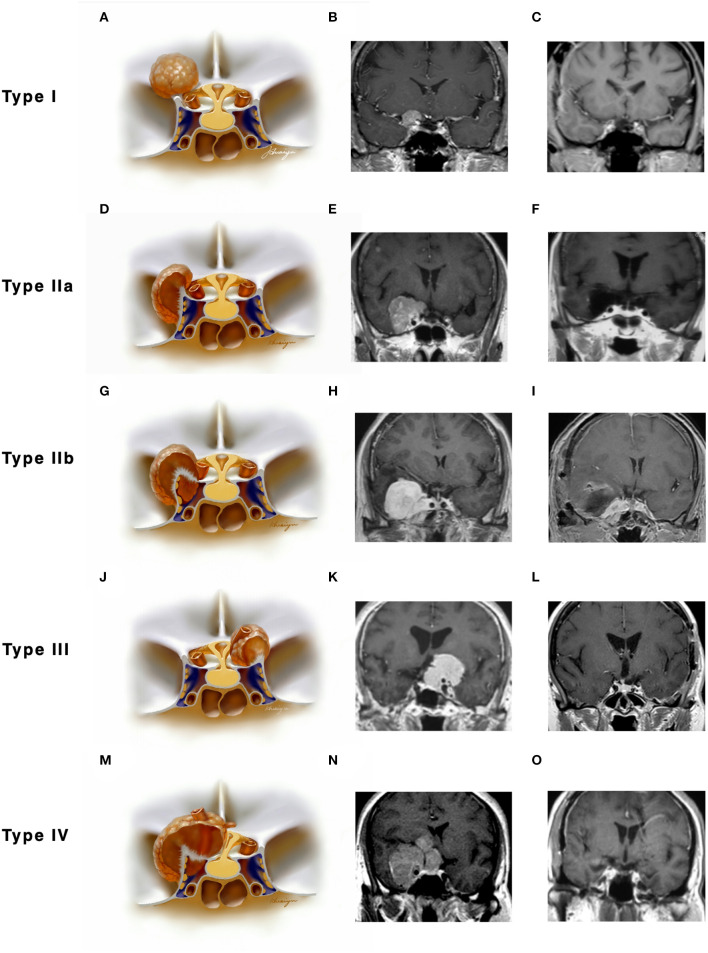
Classifications of anterior clinoidal meningiomas (ACMs) based on meningeal anatomy of the anterior clinoid process (ACP). Each horizontal panel represents an illustration of coronal sectional view, a preoperative and postoperative MR images of a type of ACMs. (A–C) Type I ACMs originate from the superior surface of the ACP. Note that the tumor may invade into the optic canal following the falciform ligament. (D–F) Type IIa ACMs originate from the lateral surface of ACP. They “attach” and “push” rather than invade the cavernous sinus because of the thick and multilayer meningeal on the lateral wall of cavernous sinus. (G–I) Type IIb ACMs originate from the tip of the ACP and grow both inside and outside of the cavernous sinus following the meningeal dura near the oculomotor triangle. (J–L) Type III ACMs that originated from the medial surface of ACP; they could affect the distal dural ring and wrap the ICA from the very beginning. (M–O) Type IV ACMs that extend to multiple directions following the meninges.